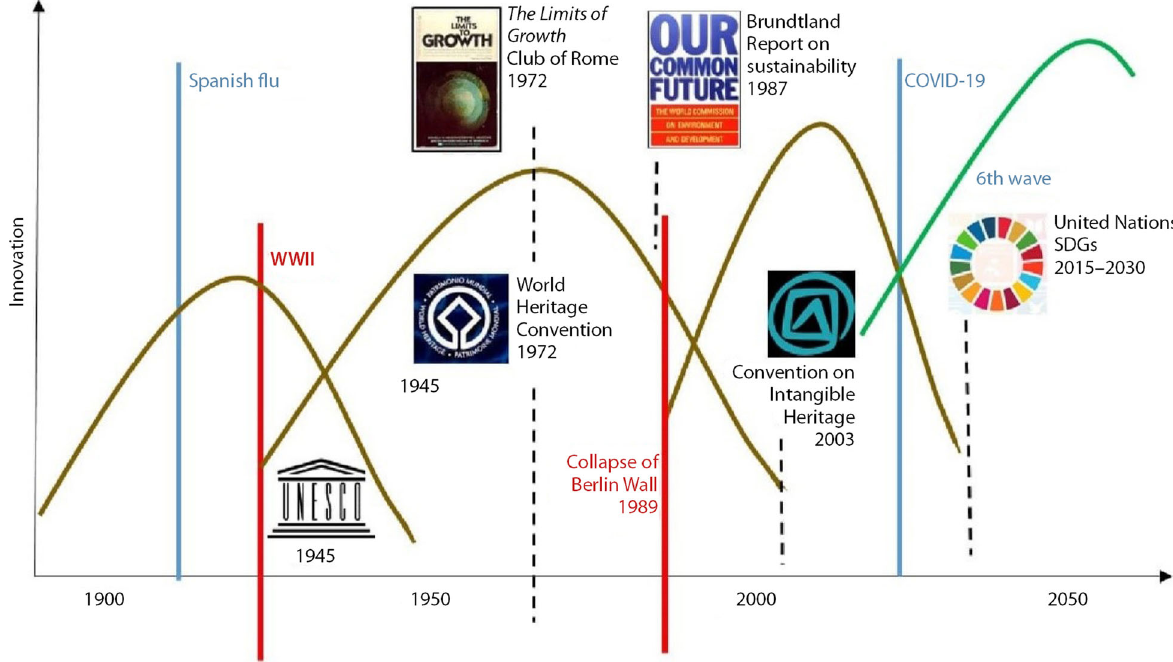
Fig. 2 Waves of innovation with the cultural built heritage (Source: the